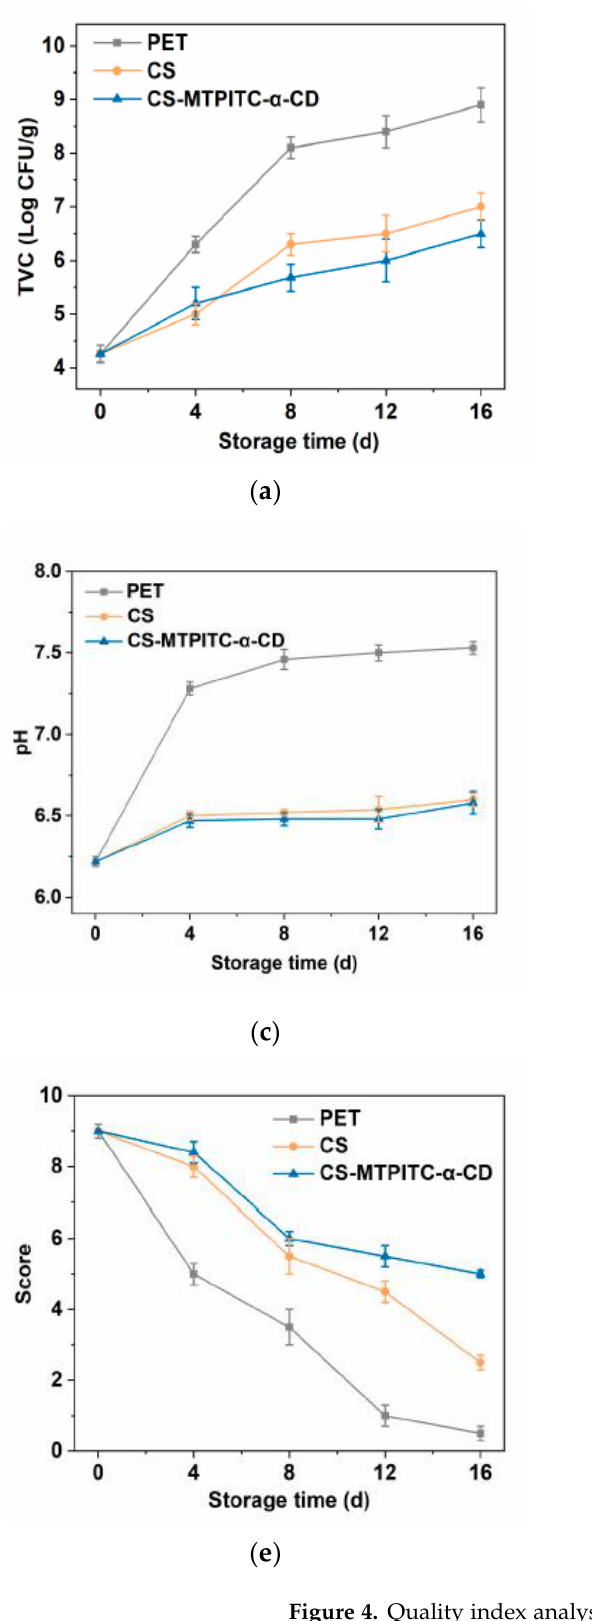
Figure 4. Quality index analysis of chicken samples wrapped with CS and CS − MTPITC −α− CD films during storage. ( a ) TVC; ( b ) TVB-N; ( c ) pH; ( d ) TBARS; ( e ) sensory evaluation.